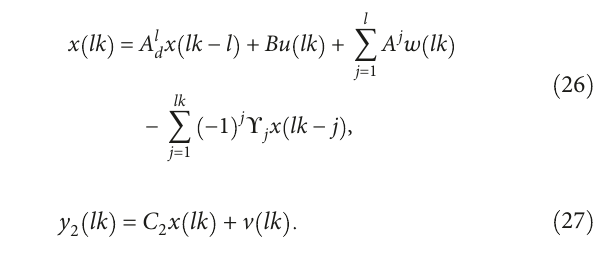
Arrival time of measurements